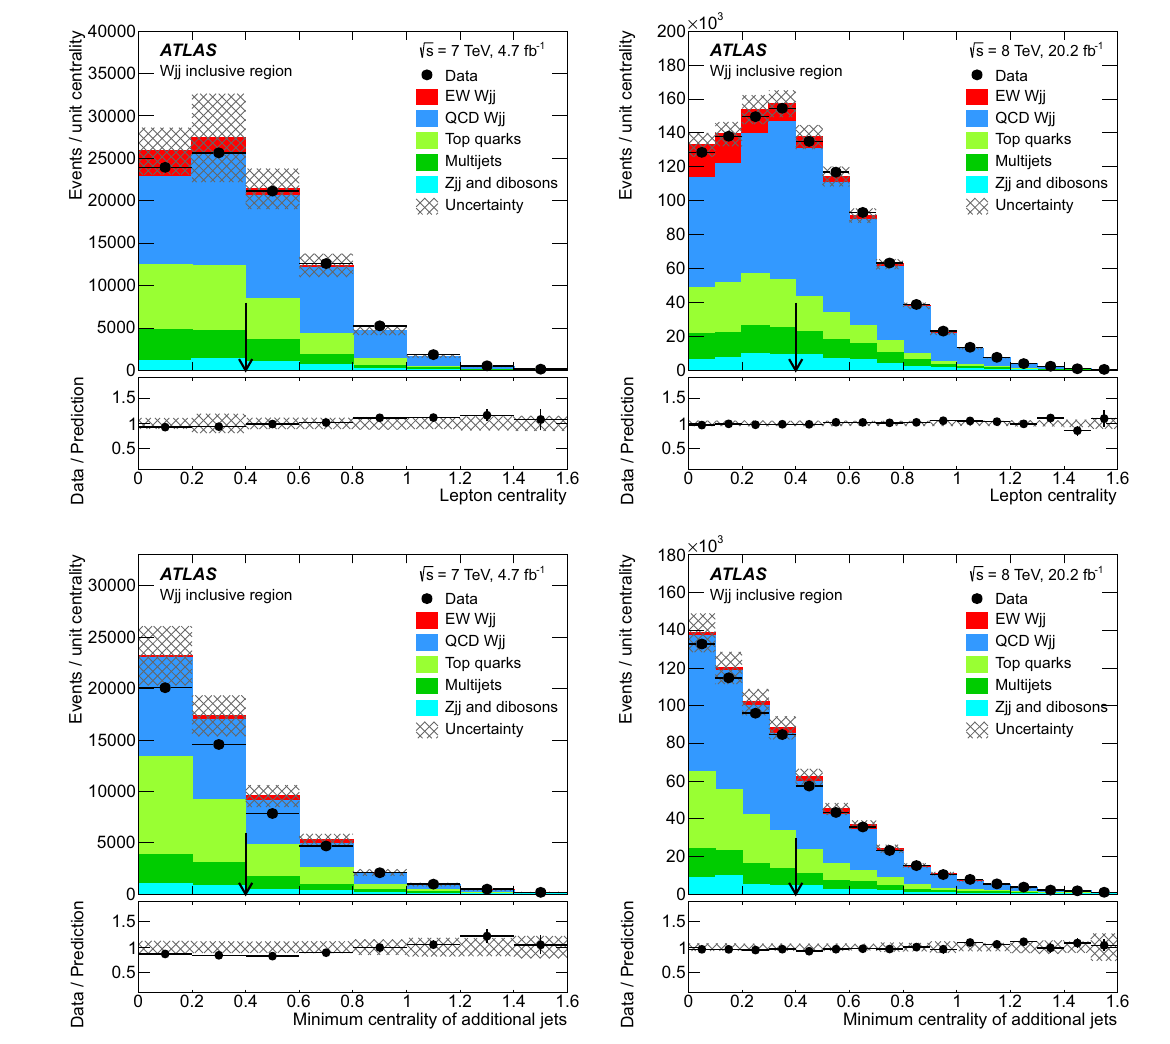
Fig. 5 Predicted and observed distributions of the lepton centrality ( top ) and the minimum centrality of additional jets ( bottom ) for events in the inclusive fiducial region (i.e. after preselection) in 7 TeV ( left ) and 8 TeV ( right ) data. The arrows in the lepton-centrality distributions separate the signal-region selection (to the left ) from the control-region